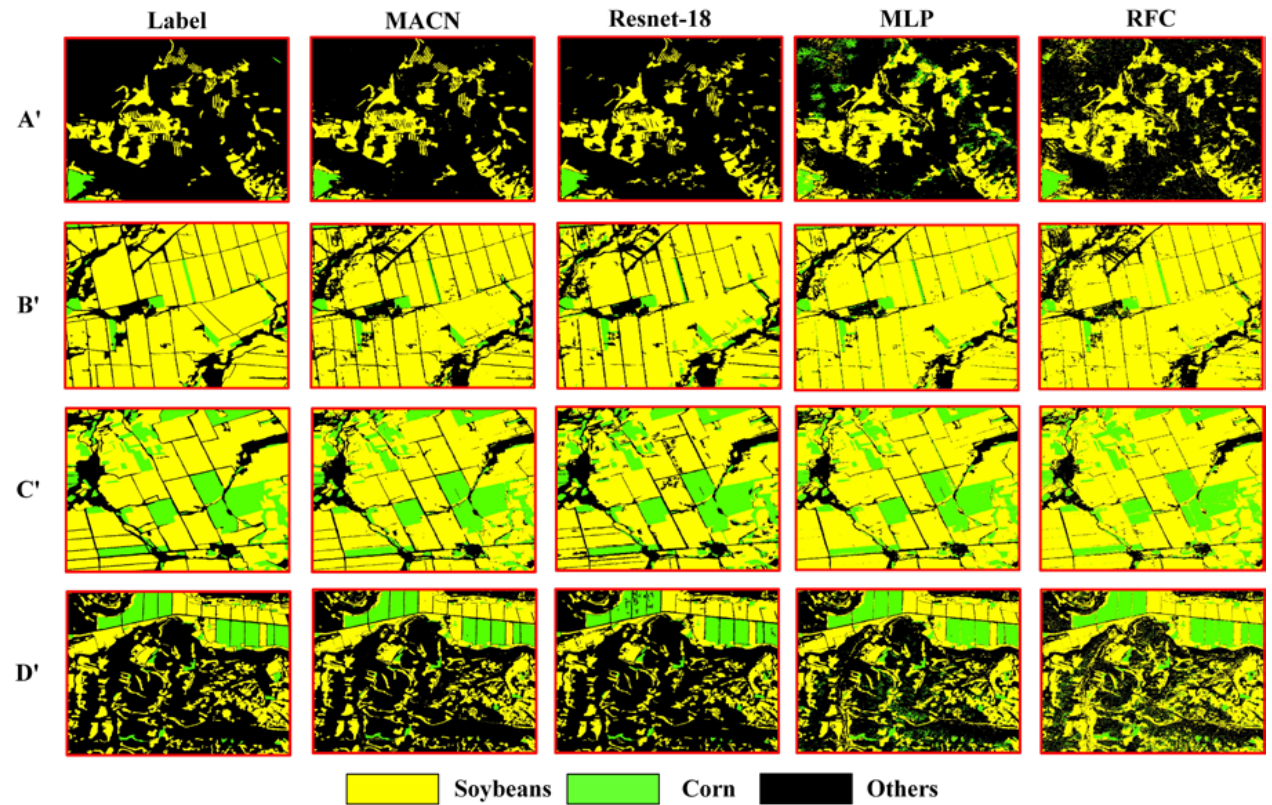
Figure 10. Enlarged views of the red boxes from the four test areas in Figure 9 (A’ corresponds to A, etc.).